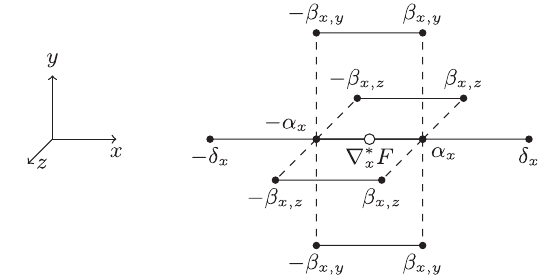
F j n in x i þ 1 = 2 ;j;k